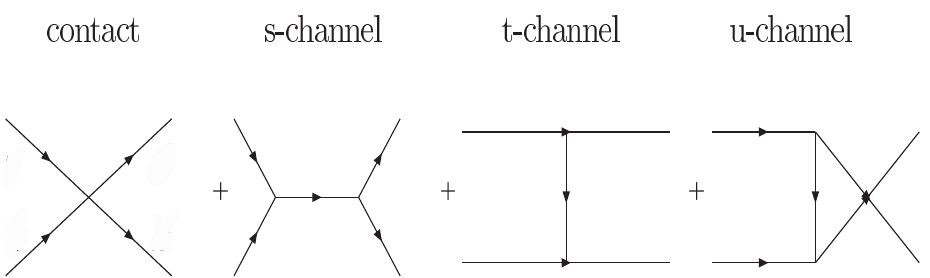
Figure 2. The 2 ↔ 2 phonon scattering processes contributing to the shear viscosity. Figure adapted from